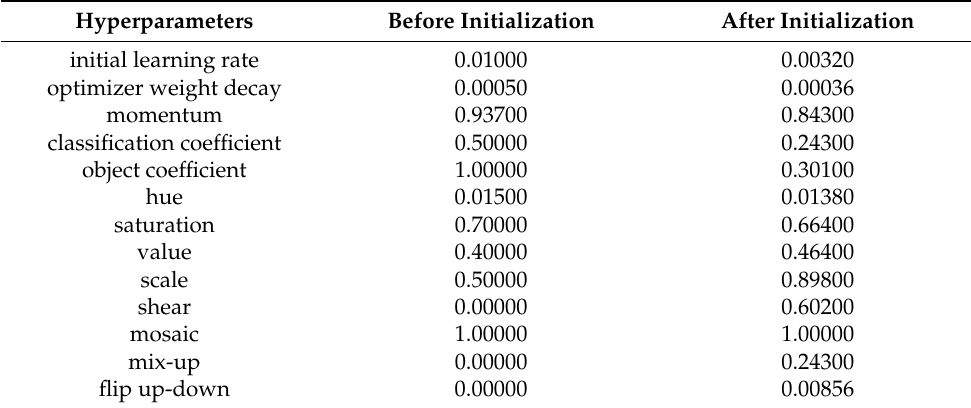
Table 4. The hyperparameters of the model.